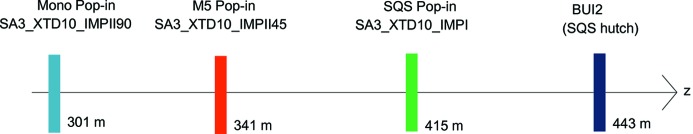
Position of the imagers used to measure the diameter of the beam at different positions along the beam propagation axes (not to scale). From this information it is possible to derive geometrically the position of the focus.